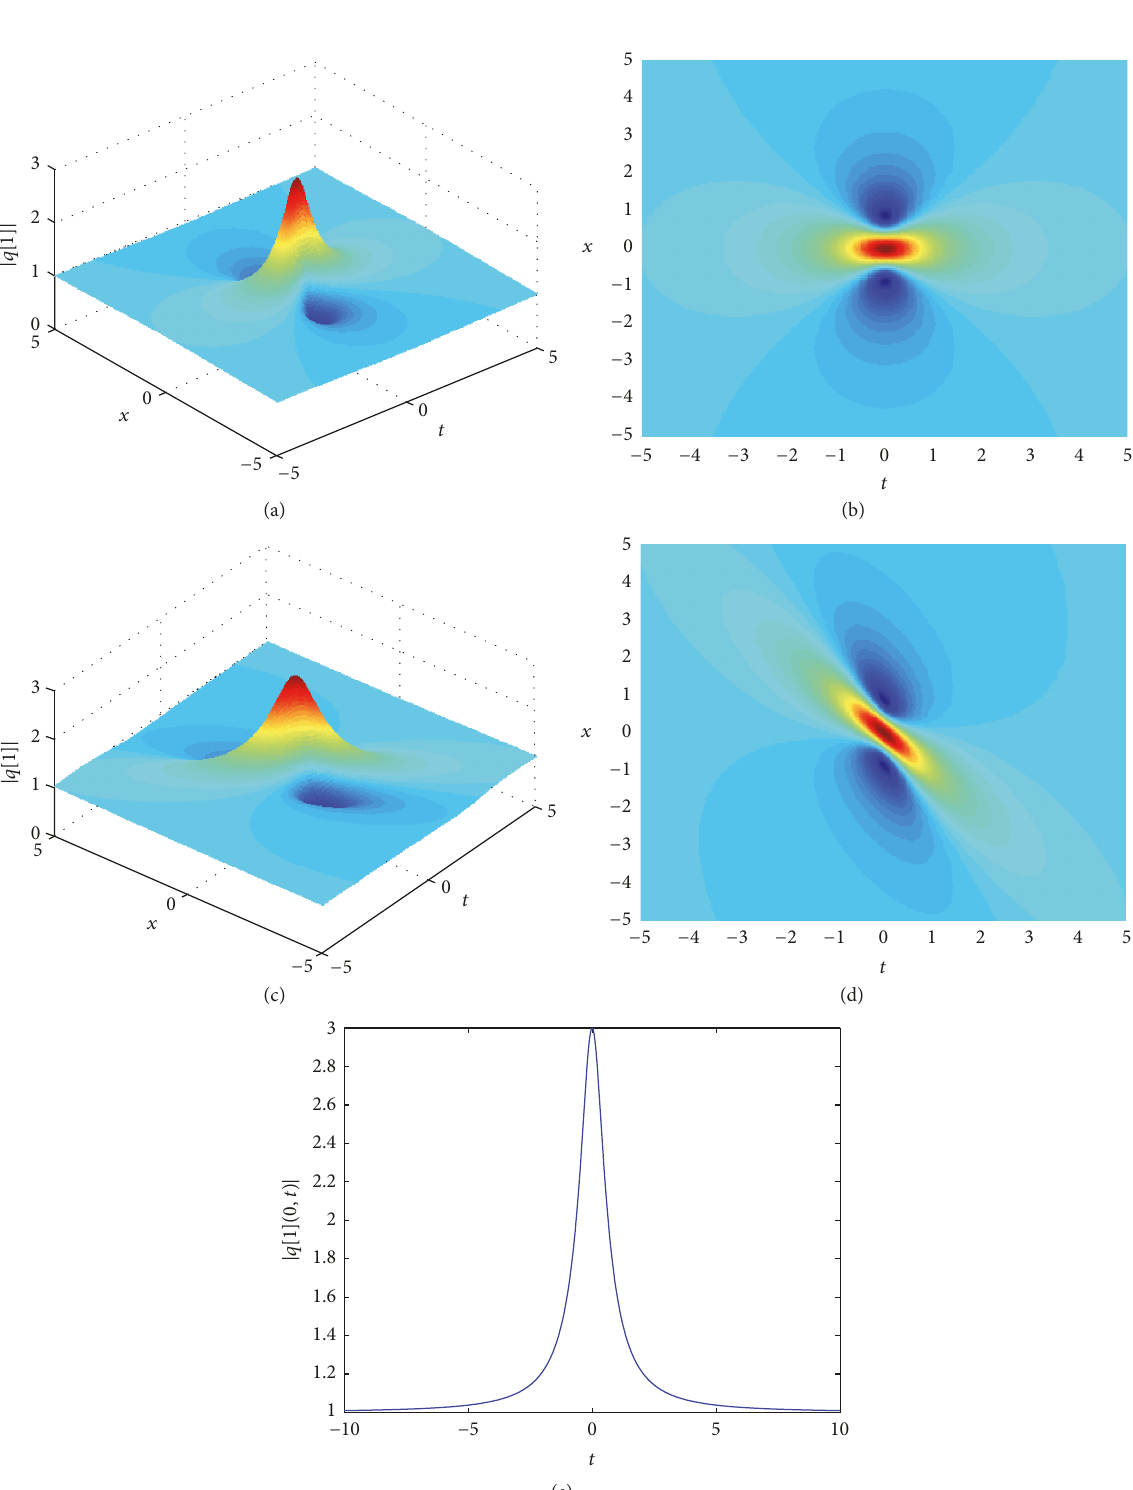
Figure 1: (a) The first-order rogue wave with 𝜀 = 0 ; (b) the density plot with 𝜀 = 0 ; (c) the first-order rogue wave with 𝜀 = 0.2 ; (d) the density plot with 𝜀 = 0.2 ; (e) the section of |𝑞[1](0,𝑡)| at 𝑥 = 0 with 𝜀 = 0